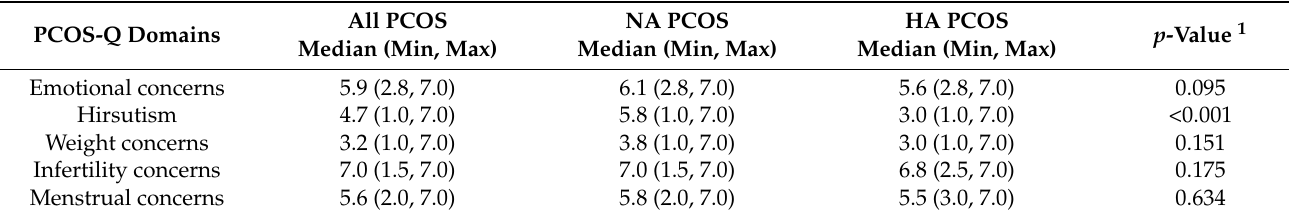
Table 4. Health-related quality of life in women with PCOS at the follow-up